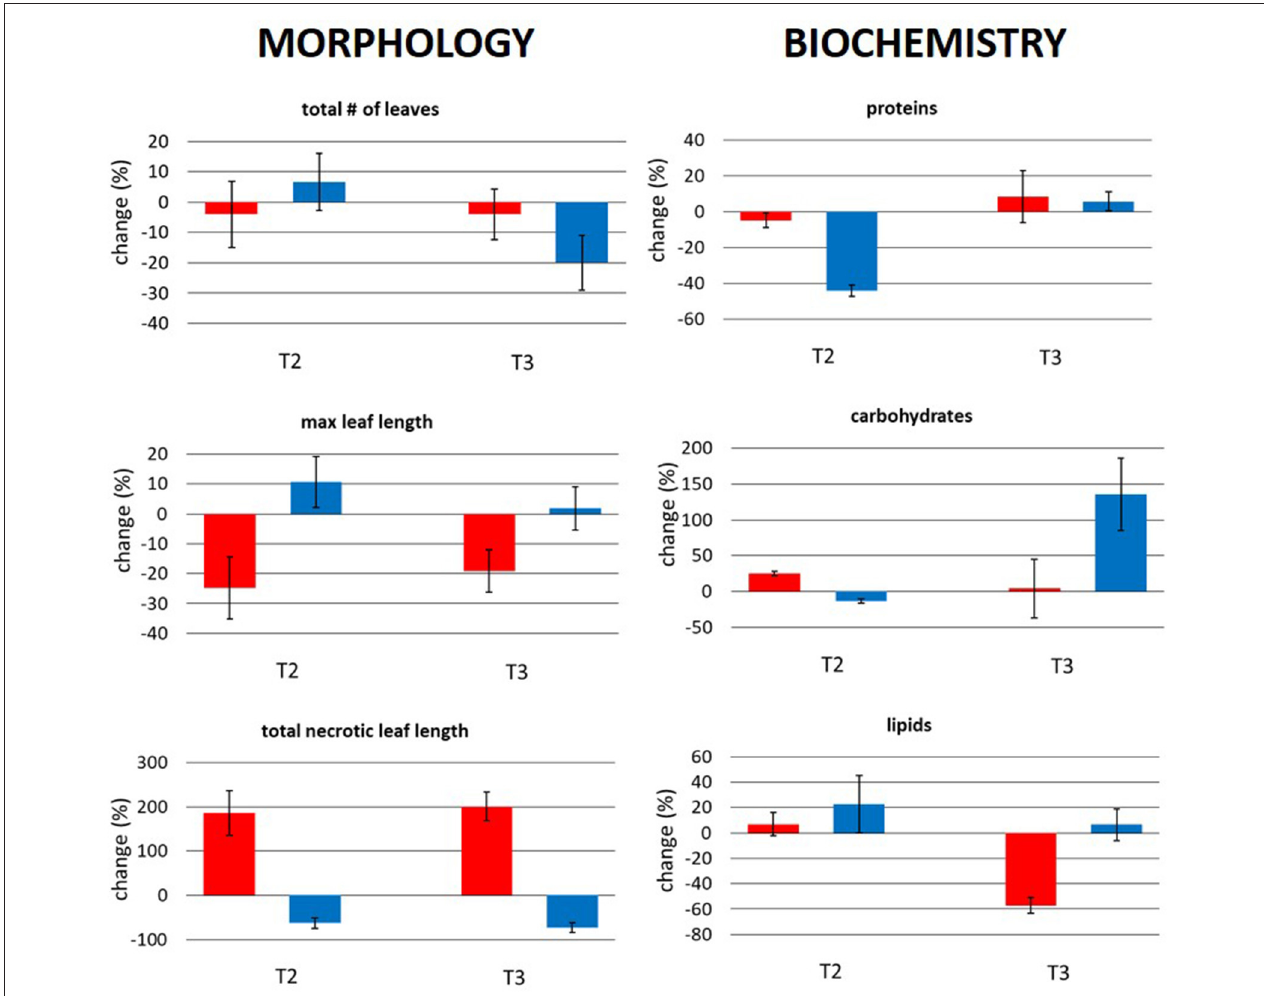
FIGURE 5 | Current MHWs. Mean change (%) in the morphological (total of leaves, max leaf length, and total necrotic leaf length) and biochemical variables (proteins, carbohydrates, lipids) at T2 and T3. Bar color corresponds to the site: red, warm site and blue, cold